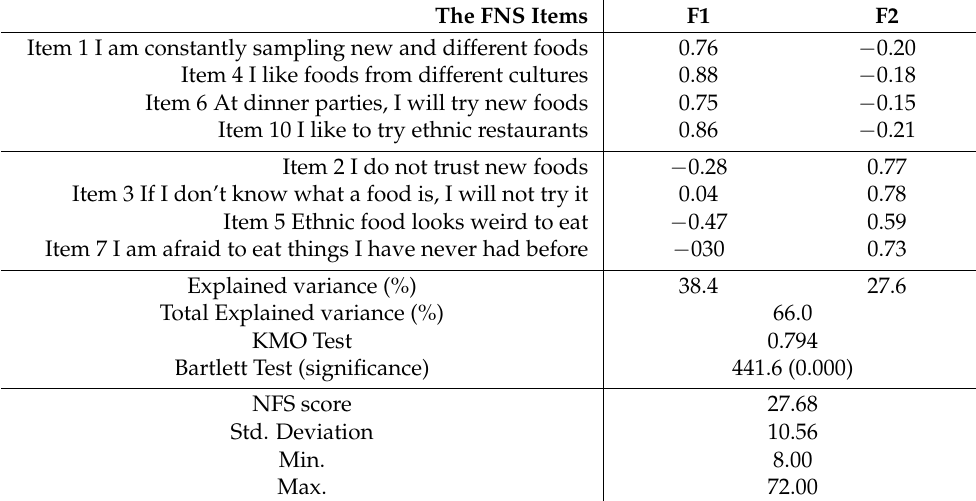
Table 5. The principal component analysis (PCA) and individual FNS score after dropping items 8 and 9.